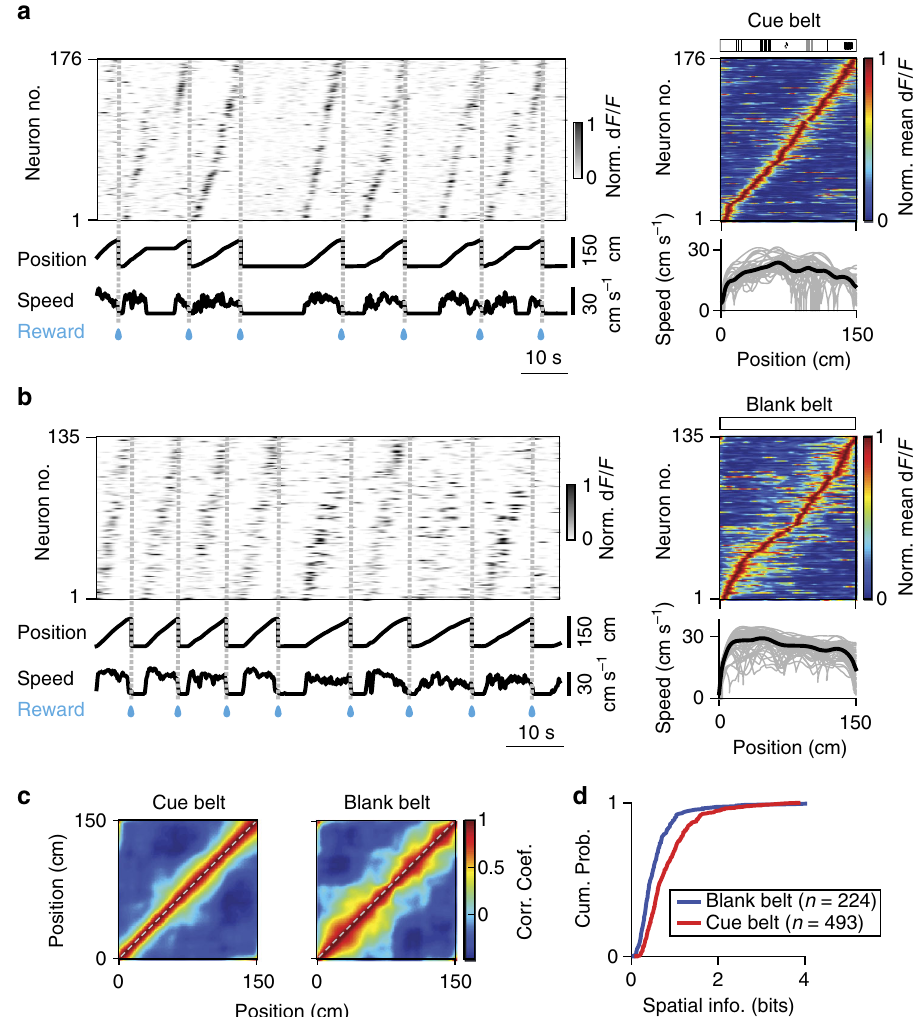
Fig. 2 Tactile stimuli enhance stability of RSC place cell activity. a ( left ) Normalized calcium activity of 176 simultaneously imaged RSC place cells on a belt with tactile cues. Cells were ordered by the positions of their peak average activity. Position and speed traces are shown below. Dashed lines and blue drops represent reward delivery. ( right ) trial-averaged position activity for the 176 RSC place cells shown on the left . Belt diagram ( top ) and speed traces as a function of position ( bottom ) are shown. Grey lines , speed traces for individual trials; black line , average speed trace. b Same, for 135 neurons imaged during movement on a belt devoid of salient tactile cues. Note the increased positional jitter of RSC place-cell activity in absence of salient tactile stimuli. c Correlation matrices (Pearson correlation coef fi cient) of population vectors as a function of position for RSC place cells on the cue belt ( left ) and on the blank belt ( right ). d Cumulative distributions of spatial information for all RSC place cells on the cue belt ( red ) and on the blank belt ( blue ). (Data from Thy1 GP4.3 transgenic